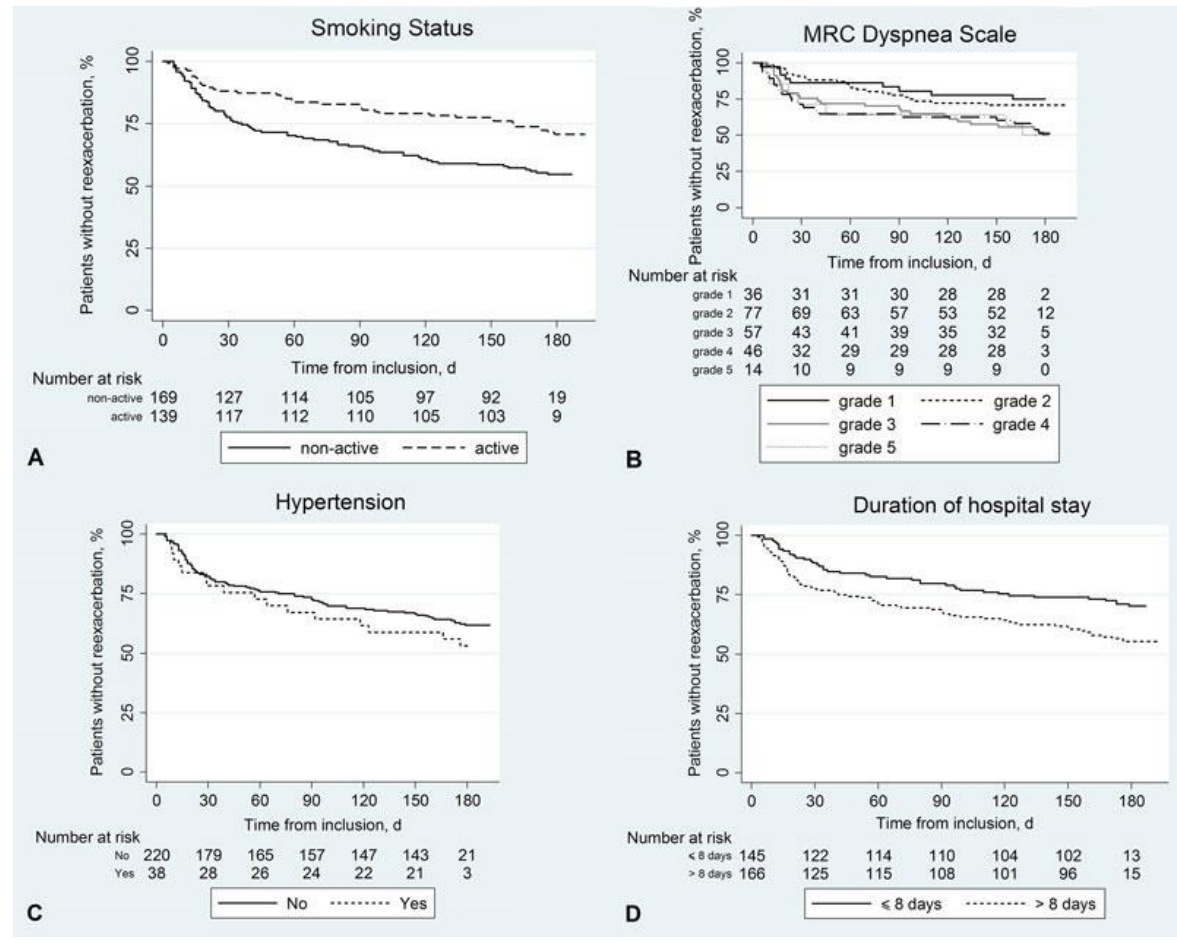
Figure 1: Survival curves according to various predictor variables at discharge. The curves show the proportions of patients without re-exacerbation during follow-up over time: (A) active smoking (yes vs no, p(log rank test) = 0.003), (B) Medical Research Council dyspnoea scale (levels 1 to 5, p = 0.02), (C) hypertension (yes vs no, p = 0.30) and (D) duration of hospital stay (>8 vs  8 days, p =